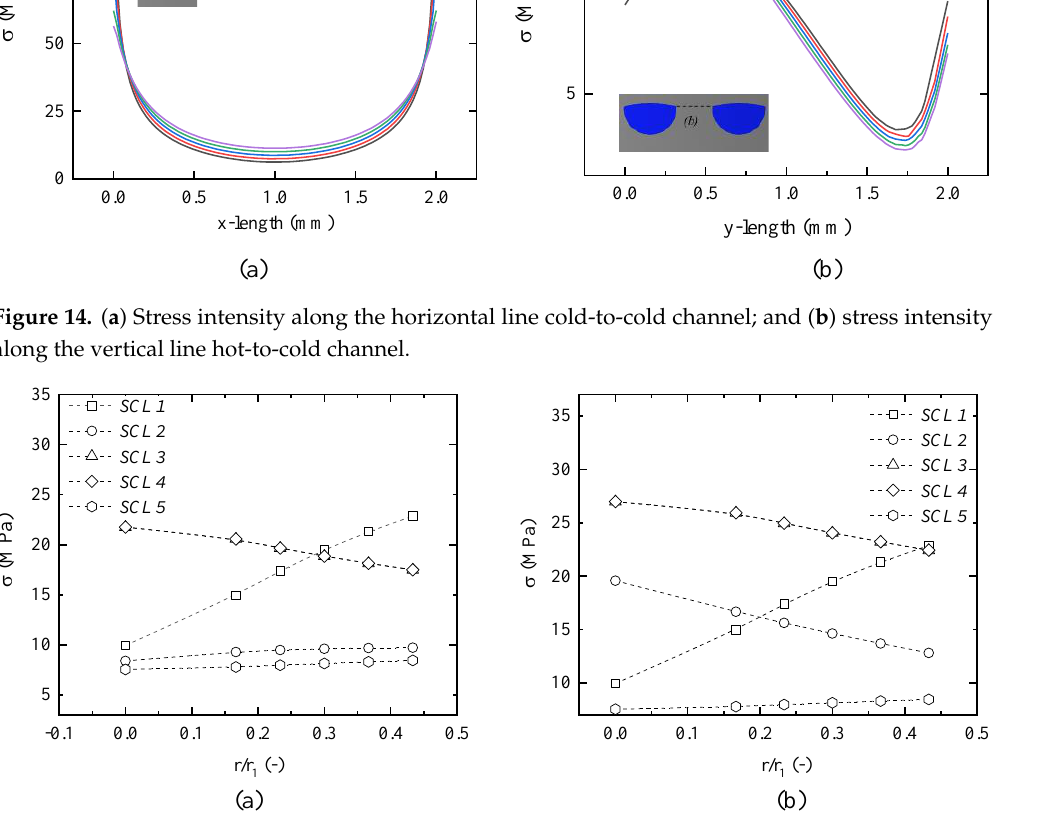
Figure 15. Stress linearization result at all SCLs at the different elliptical shape radii: ( a ) primary membrane stress; and ( b ) primary + bending stress.